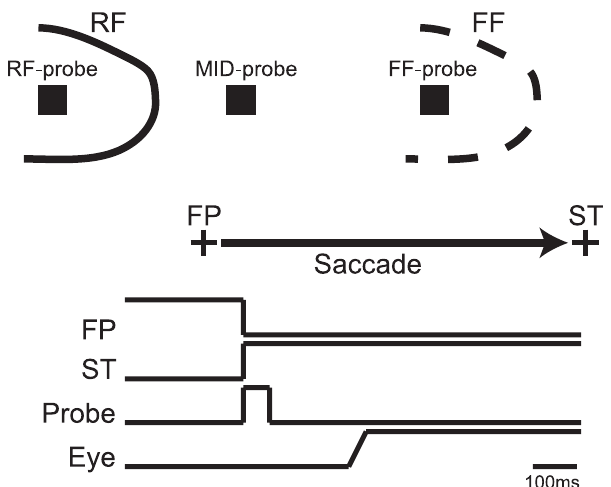
Figure 1. The remapping paradigm. Sketch of the spatial (A) and the temporal (B) properties of the different experimental conditions in the remapping paradigm. A: A visual probe was flashed at different positions in the visual field. Across different, randomly-interleaved conditions, the probe appeared in the receptive field of the neuron (RF- probe), the future field (FF-probe), and at the midpoint between the two (MID-probe). B: The lines represent the relative timing of the fixation point (FP), the saccade target (ST), the remapping probe (Probe) and a typical eye movement (Eye). After the monkeys had fixated for a random duration, the fixation point was extinguished and at the same time the saccade target and the remapping probe appeared. The saccade target remained on for the rest of the trial, while the probe lasted for 59 ms. The monkey made a saccade to the target with a latency that was typically . 120 ms; thus the offset of the visual probe and the start of the saccade were separated by at least 60 ms.